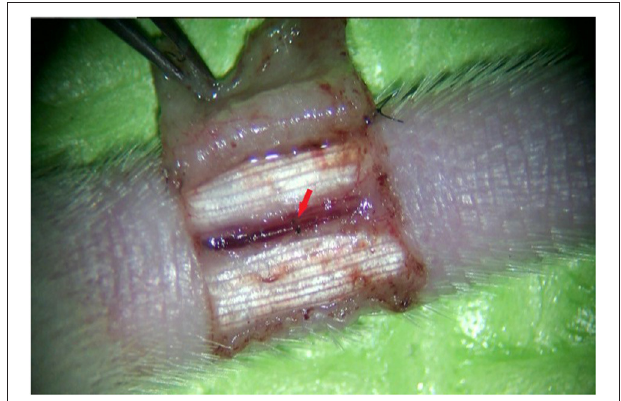
FIGURE 3 | The mouse middle caudal artery was exposed with the measurement of the diameter.